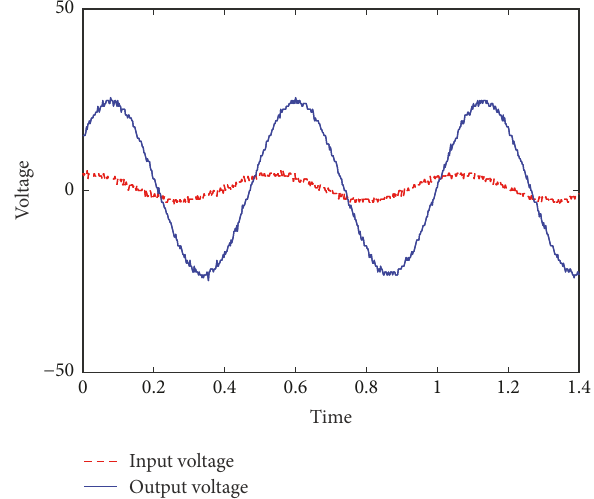
Figure 11: Measured input and output voltage waveforms.